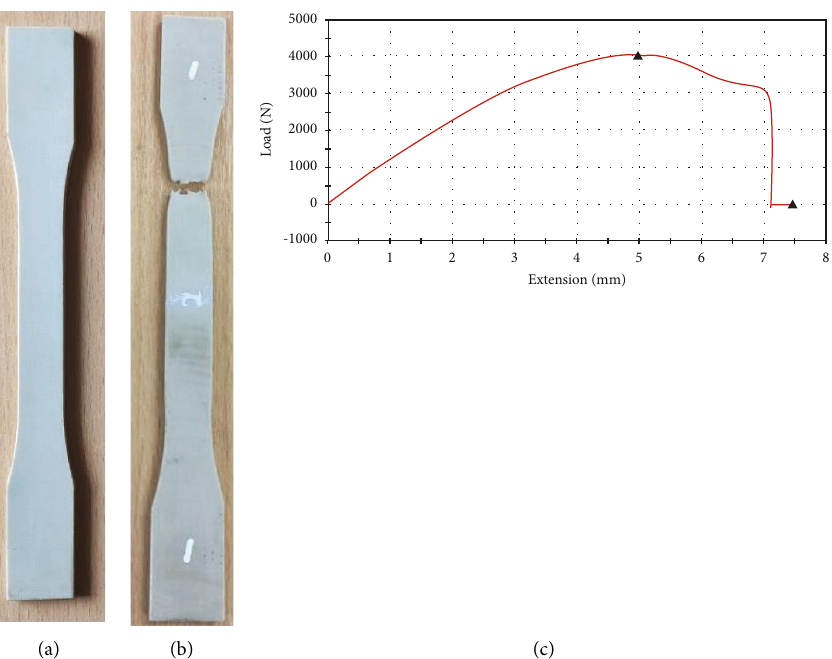
Figure 1: (a) PEEK sample; (b) broken sample; (c) load-displacement diagram.